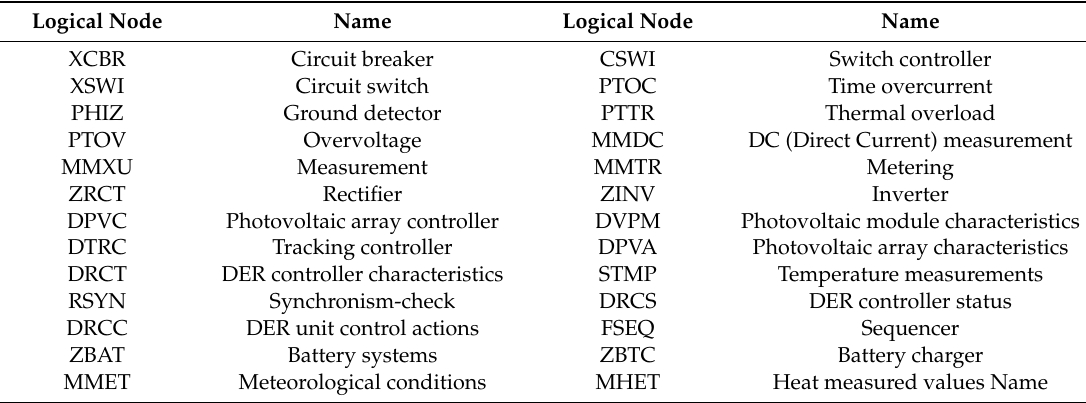
Figure 3. Example of logical nodes (LN) associated with photovoltaic systems. Table 1. Abbreviations for logical nodes.